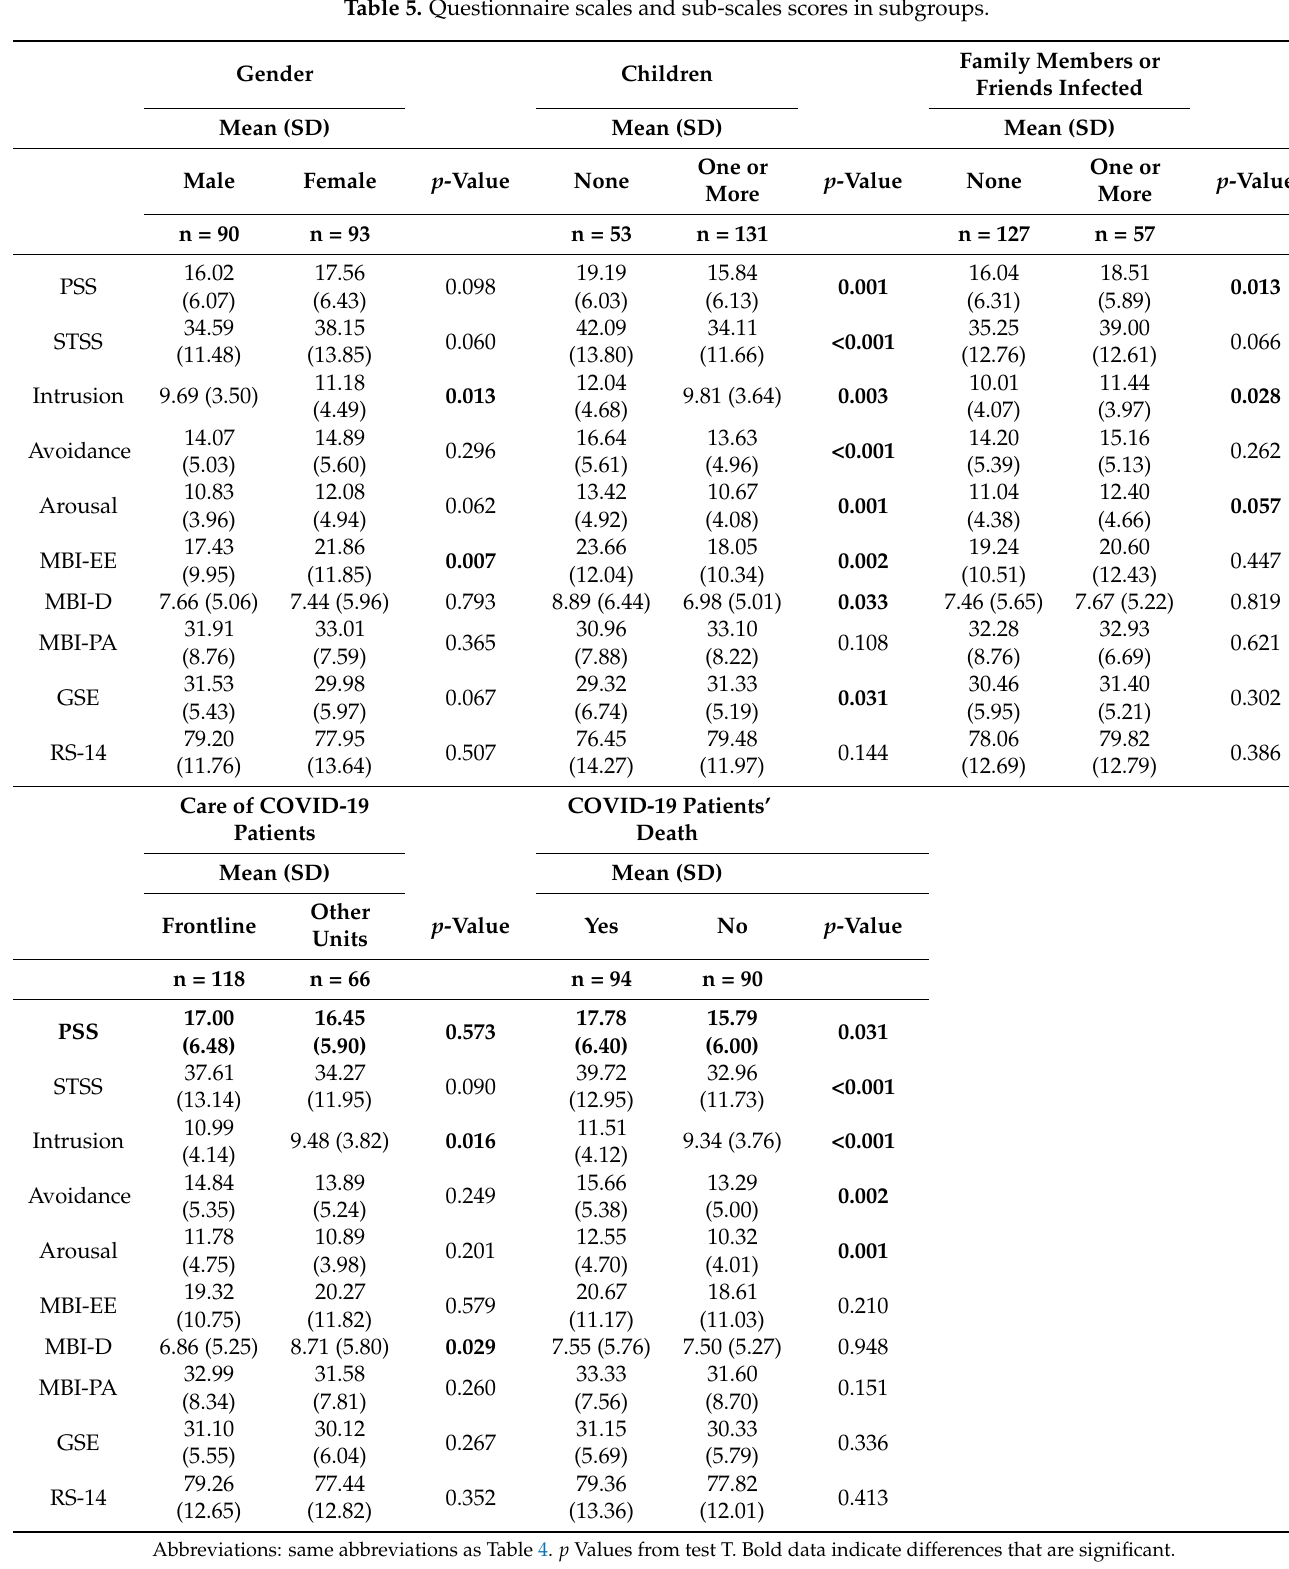
Table 5. Questionnaire scales and sub-scales scores in